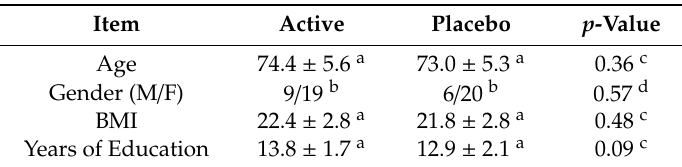
Table 2. Participant Characteristics